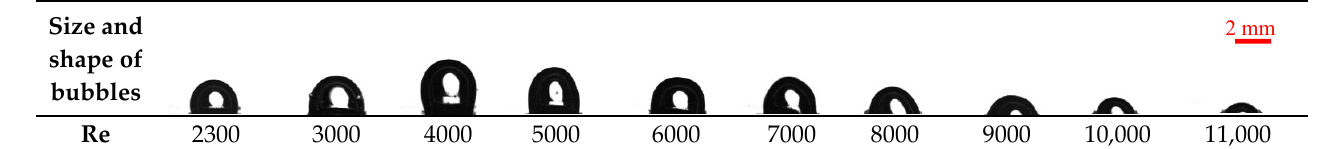
Figure 19. The shape of bubbles under different Reynolds numbers.